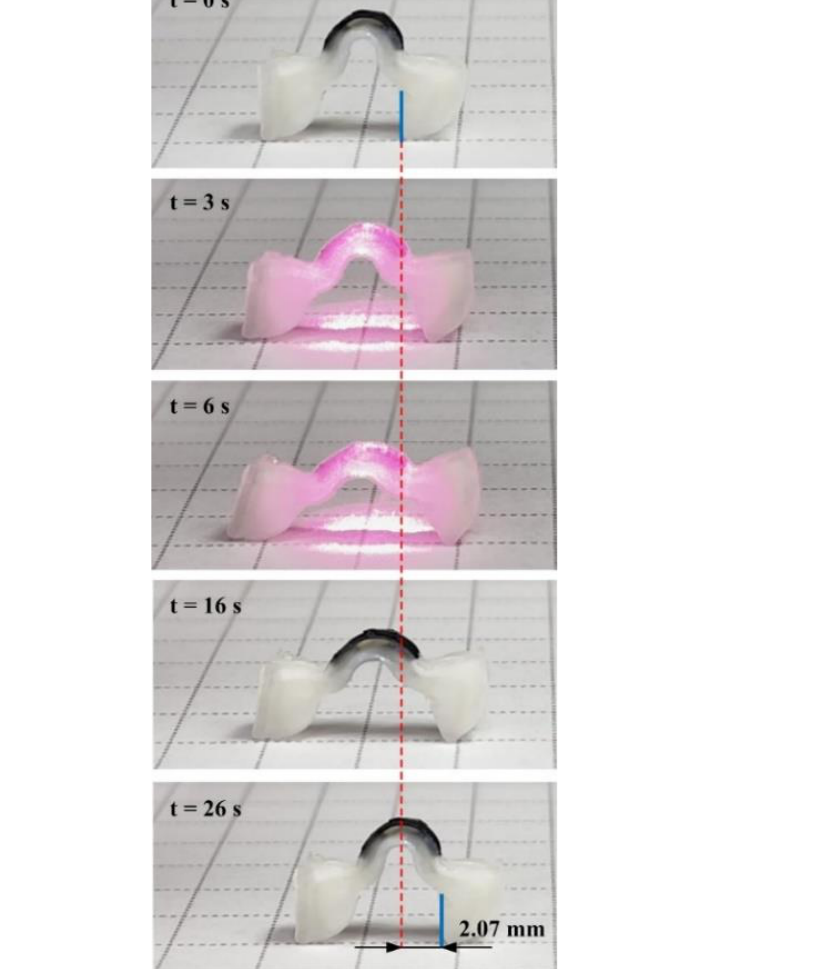
Figure 10. The snapshot images of an LCE crawler (Device-B) for one actuation cycle.